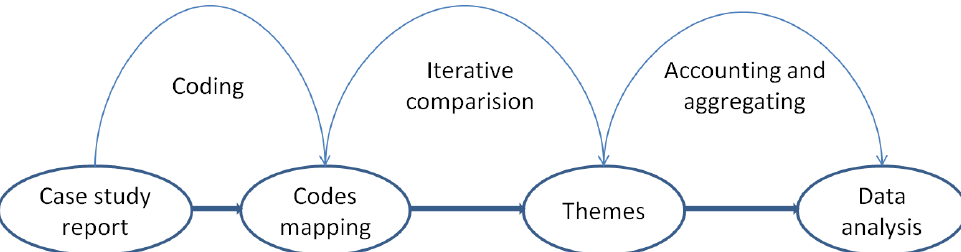
Figure 2. Adoption of the thematic analysis methodological process.